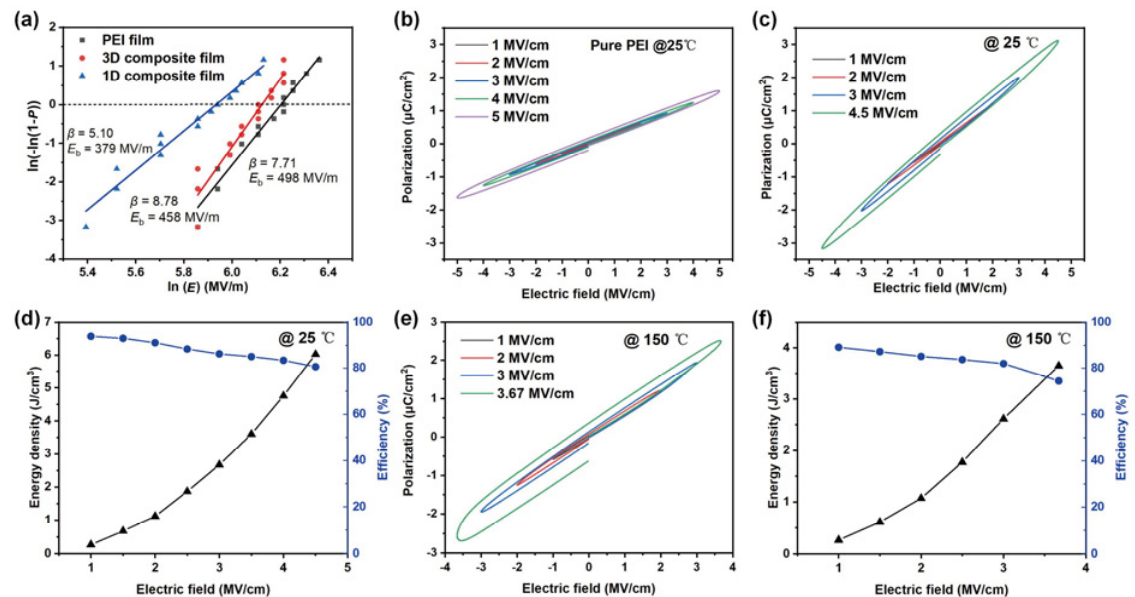
Fig. 5 Energy storage performance of PEI-based composite films. (a) Two-parameter Weibull distribution analysis of pristine PEI, PEI-based 1D composite film, and 3D composite film. D – E curves of (b) pure PEI and (c) 3D composite film at 25 ℃ . (d) Discharge energy density and charge–discharge efficiency of 3D composite film at 25 ℃ . Energy storage performance of 3D composite film at a high temperature of 150 ℃ : (e) D – E curves at different electric fields and (f) discharge energy density and charge–discharge